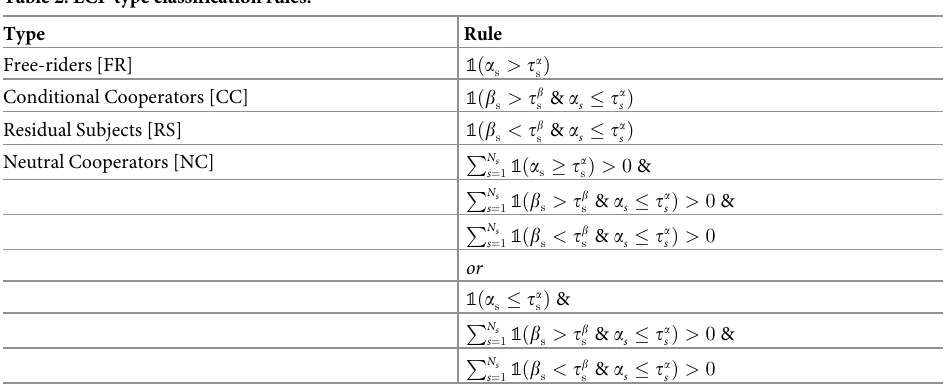
Table 2. LCP type classification